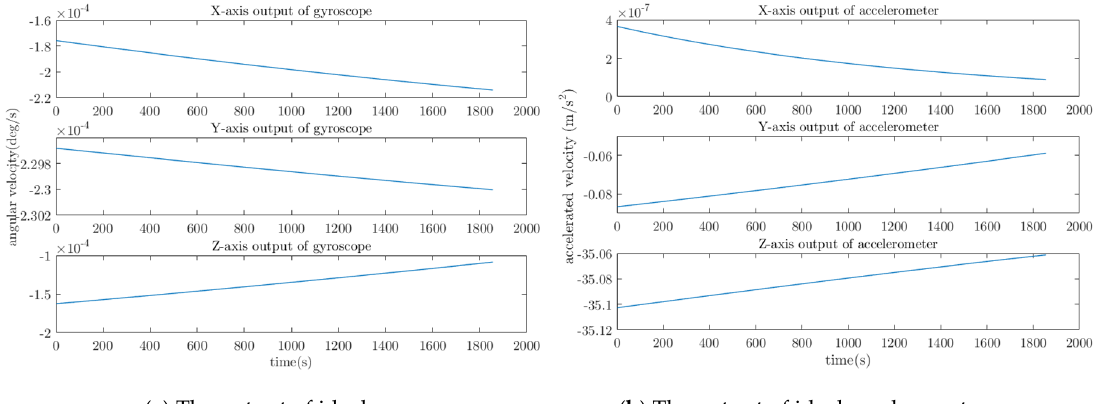
Figure 4. The output of ideal inertial sensor.